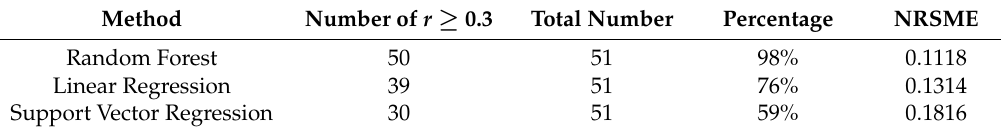
Table 3. Overall SH features used to predict the variables of the second smart home (IAQ 2 ).